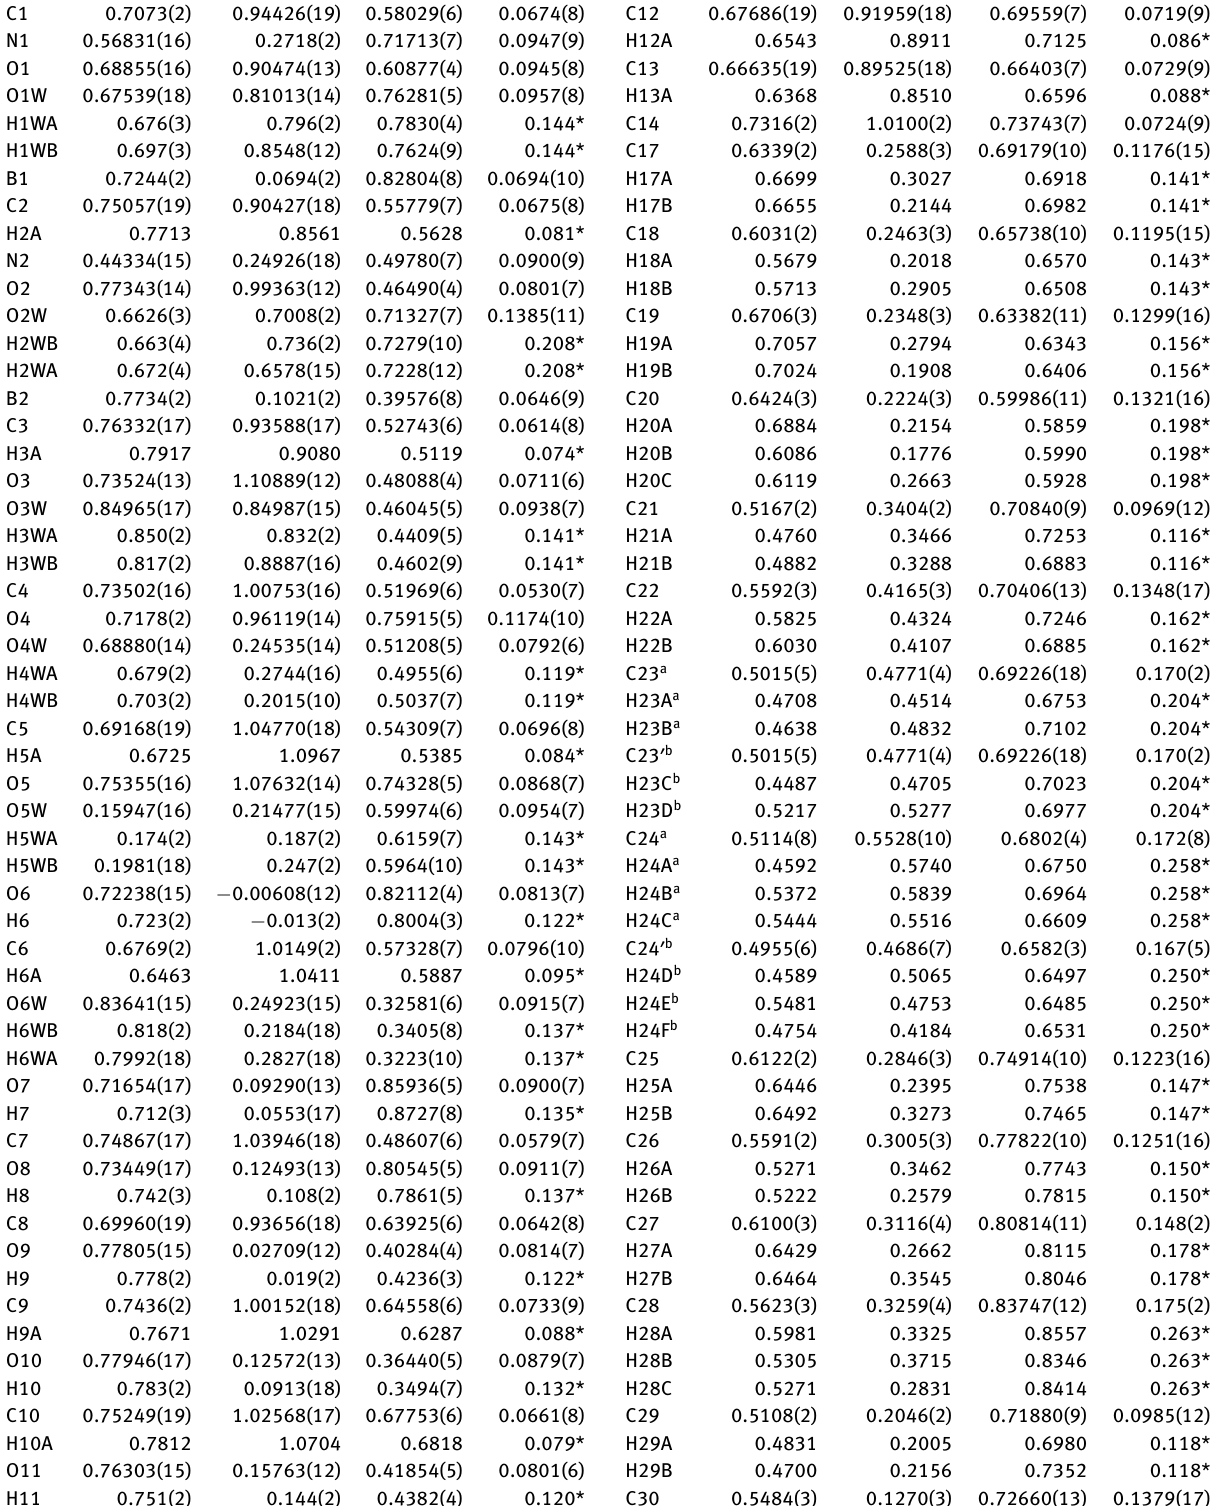
Table 2: Fractional atomic coordinates and isotropic or equivalent isotropic displacement parameters (Å 2